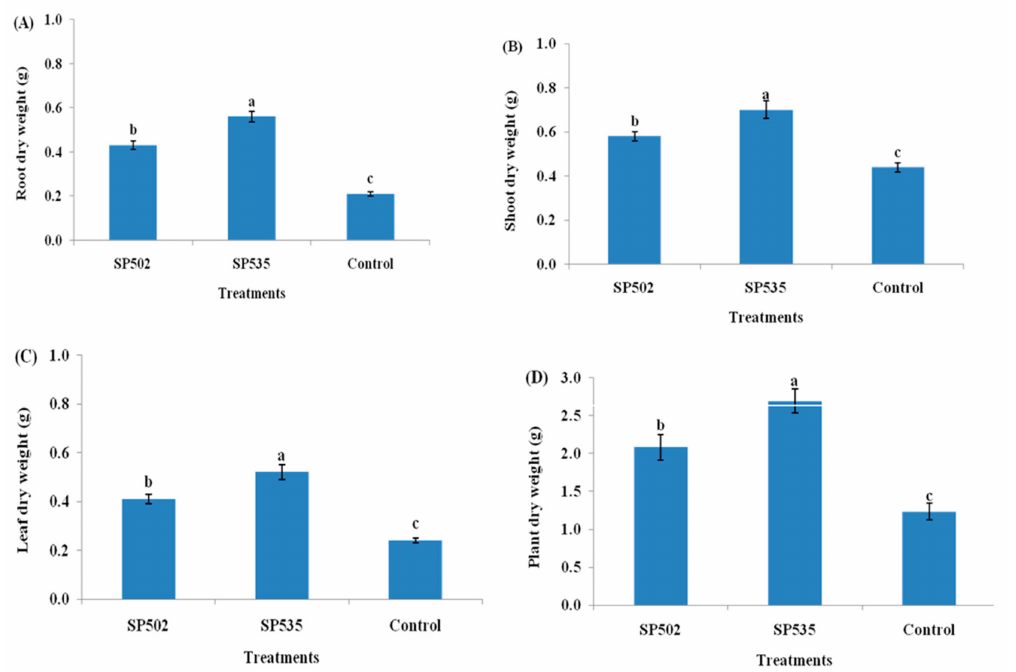
Figure 3. E ff ect of Cordyceps fumosorosea isolates on dry weights of di ff erent plant parts after 60 days of fungal treatment. ( A ) Root dry weight; ( B ) shoot dry weight; ( C ) leaf dry weight; and ( D ) total plant dry weight. Error bars indicate the standard error of means based on five replicates (n = 5). Bars having di ff erent letters indicate that means are significantly di ff erent from each other at 5% level of